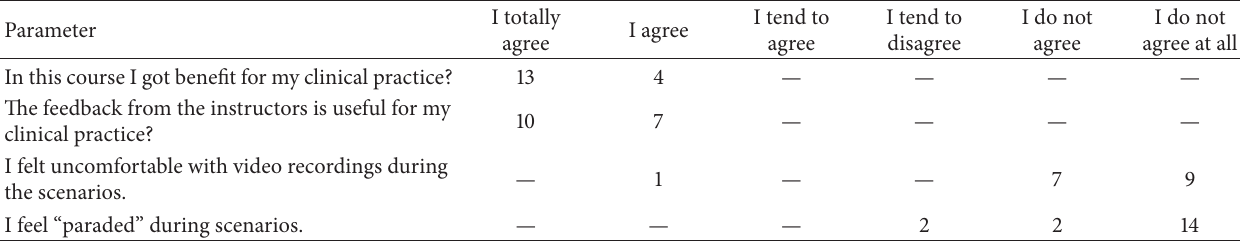
Table 3: Individual marks of the course elements ( 𝑛 = number of